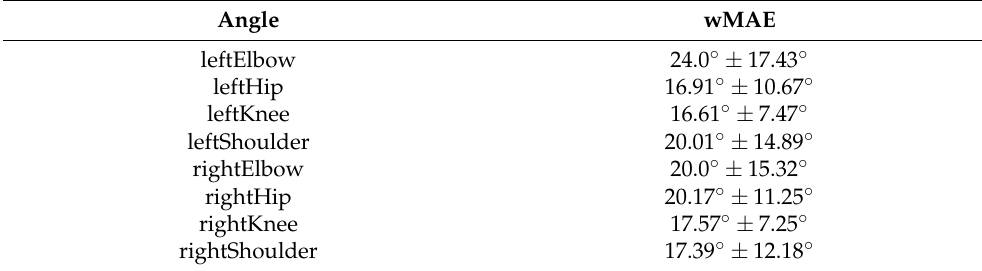
Table 1. The aggregated wMAE values for all joint